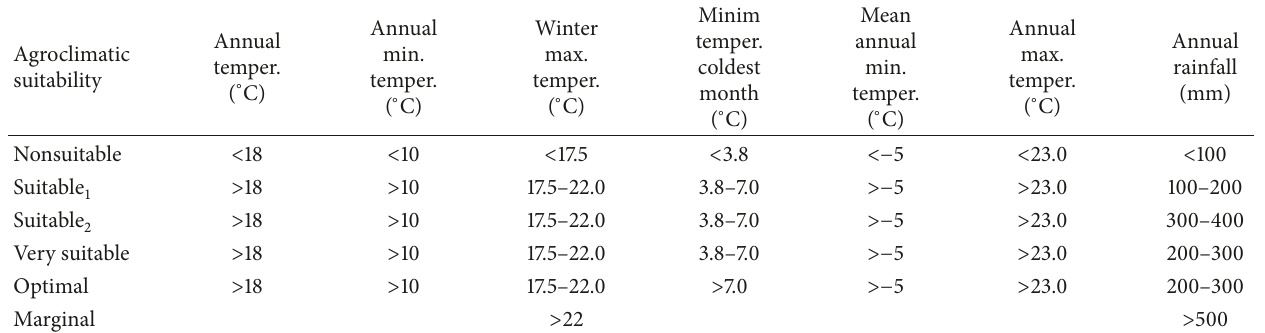
Table 2: Classes of agroclimatic suitability and limits for each class.